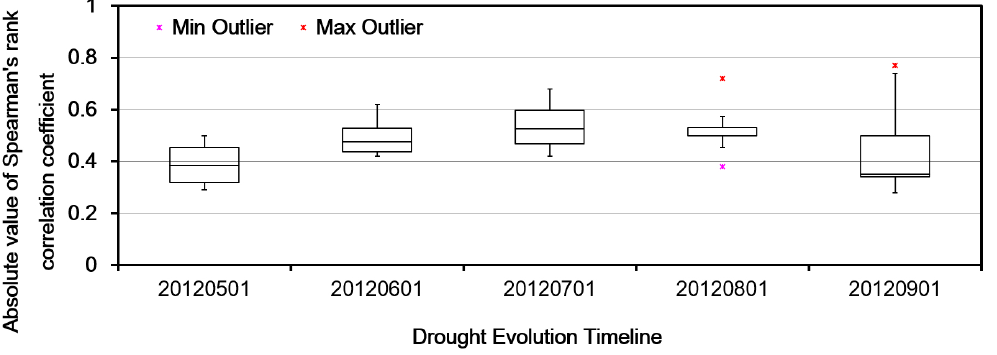
Figure 10. Box plots of correlations between YAI and SPI-12 from the beginning of drought to the end in twelve states in the Midwest. Spearman’s correlation coefficients were considered only at significant level of 5%.